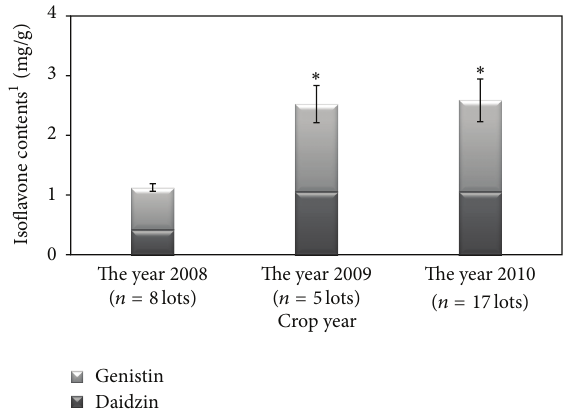
Figure 7: Isoflavone content in sound seeds of Chiangmai 60 soybean variety grown in different crop years and obtained from Chiang Mai Field Crops Research Center. The soybean samples from each crop year were obtained from different lots. Each lot was extracted and assayed in triplicate. ∗ 𝑃 < 0.05 compared to the year 2008. Bars and error bars represent mean ± standard deviation. 1 Isoflavone content was the summation of daidzin and genistin